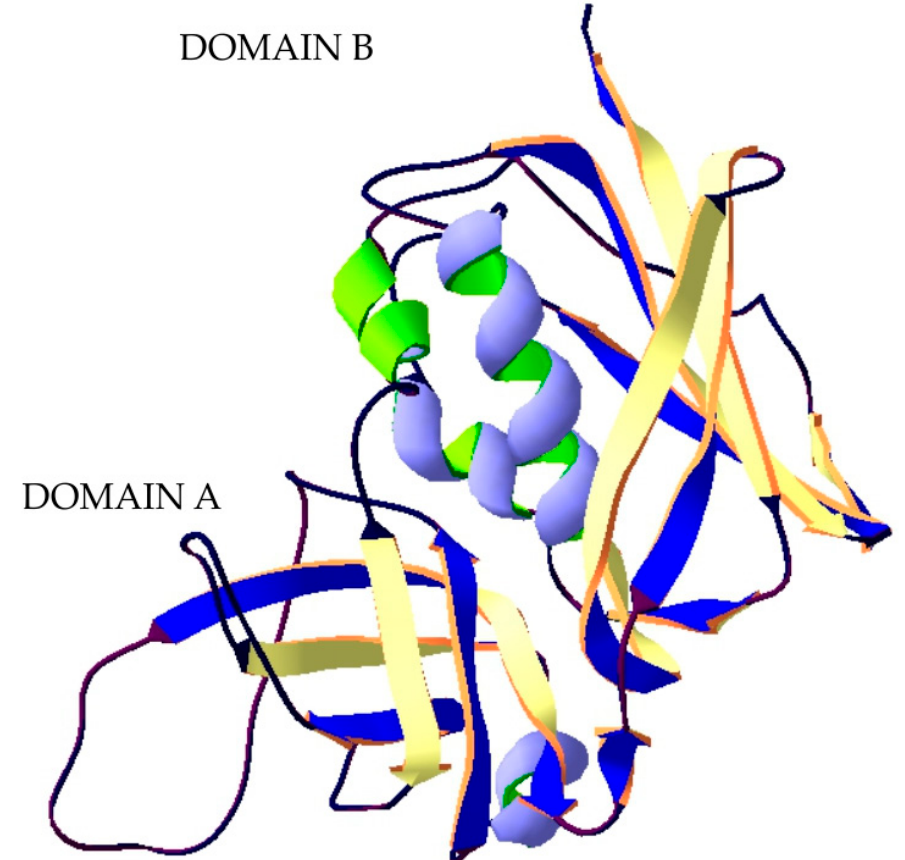
Figure 2. Structure of Staphylococcal enterotoxin B. The crystal structure of protein (PDB: 3SEB) [53] was taken from the RCSB PDB databank (http://www.rcsb.org/) (access on 08.03.2018).